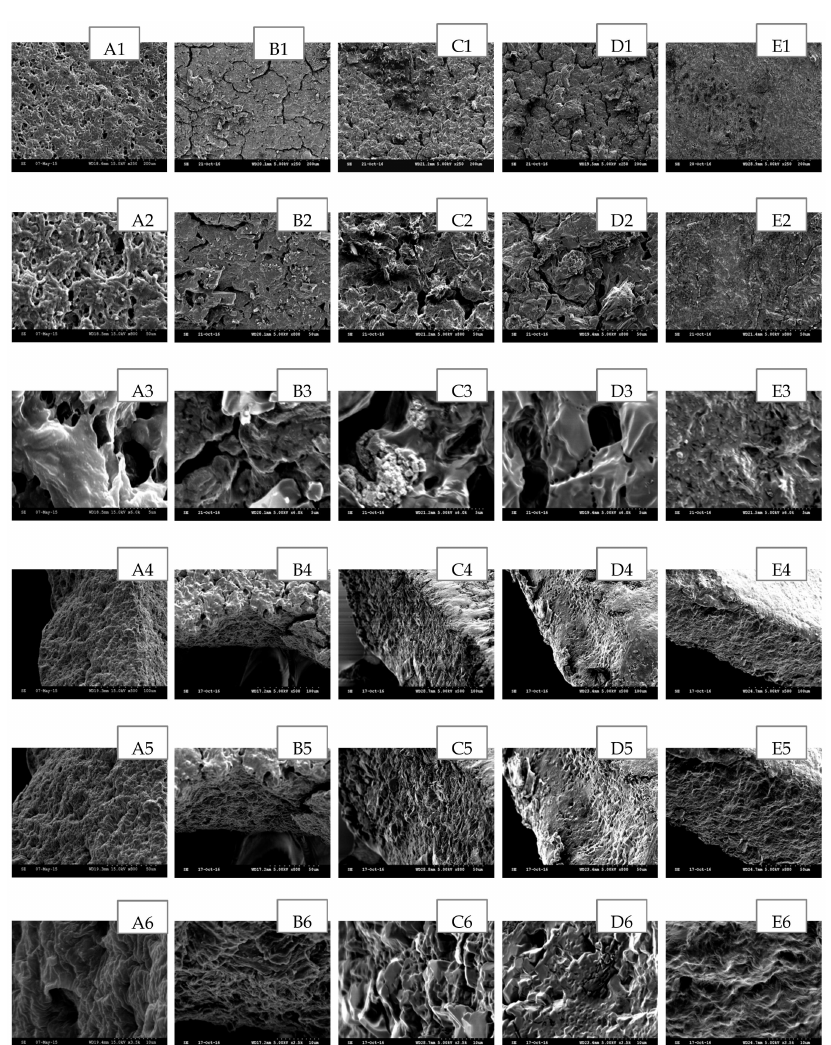
Figure 2. SEM images of post-loaded LID hydrogel network in comparison to unmedicated hydrogel cross-linked with 5% w / w PETRA. ( A ) Unmedicated PEO, ( B ) PEO-LID 1.18% w / w (25% saturation), ( C ) PEO-LID 3.64% w / w (50% saturation), ( D ) PEO-LID 6.31% w / w (75% saturation), ( E ) PEO-LID 9.75% w / w (100% saturation). Scale bars are 100, 50 and 5 µ m for micrographs featuring the outer surface of hydrogel network (1–3), 100, 50, and 10 µ m for micrographs featuring the cross section of hydrogel network